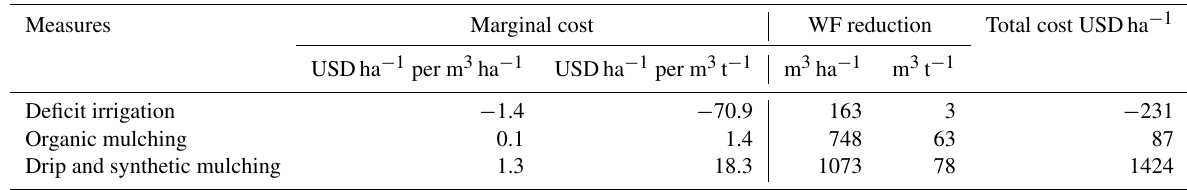
Table G2. Marginal cost and WF reduction per subsequent measure in the MCC for WF reduction in maize production for the baseline of sprinkler irrigation combined with full irrigation and no mulching.